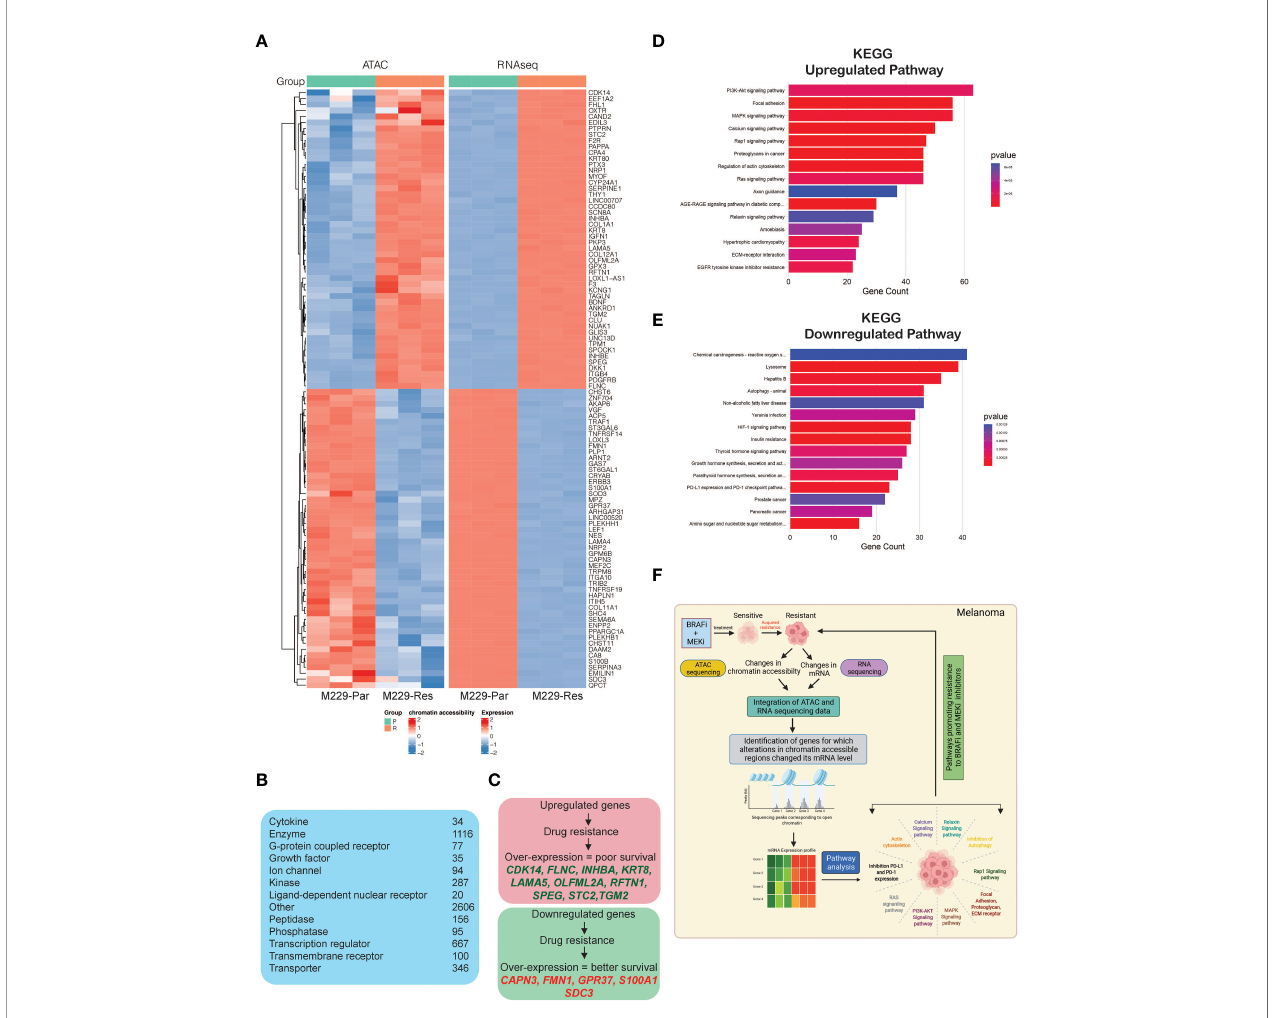
FIGURE 4 | Integrated analysis of ATAC-sequencing and RNA-sequencing to identify differentially expressed genes between M229-Par and M229-Res cells for which changes in mRNA expression aligned with changes in chromatin accessibility. (A) Heatmap for the top 100 (50 upregulated or with increased chromatin accessibility and 50 downregulated or with reduced chromatin accessibility) genes showing similar patterns in both the ATAC-seq and RNA-seq analyses in M229- Res cells compared with M229-Par cells. (B) Genes obtained integrated from analysis categorized based on function. (C) Survival analysis (3-year) for patients with melanoma according to high and low expression levels of genes showing similar patterns in both the ATAC-seq and RNA-seq analyses in M229-Res cells compared with M229-Par cells using the Human Protein Atlas dataset. (D, E) KEGG pathway analysis showing key upregulated (D) and downregulated (E) biological pathways associated with genes that display coherence between changes in chromatin accessibility and changes in mRNA expression levels in M229-Res cells compared with M229-Par cells. (F) Model: ATAC-seq integrated with RNA-seq is a new and advanced approach for identifying unique changes in chromatin accessibility regions that modulate gene expression and signaling pathway activities to promote the MAPK pathway inhibitor